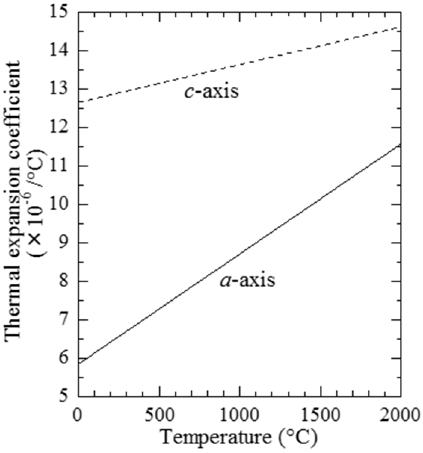
Figure 5. Temperature dependence of thermal expansion coefficients (TECs) of a - and c -axes for SCAM crystal. The linear relationships of them are extrapolated up to 2000 °C.